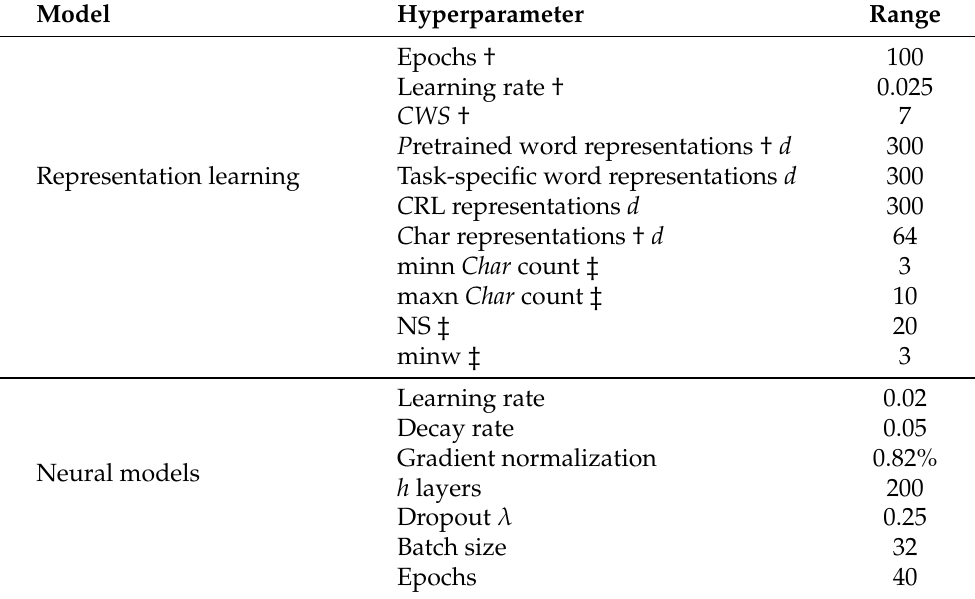
Table 4. Optimal hyperparameters for pretrained word-level and character-level (Char) SdGloVe and SdfastText representations, neural baselines, and the proposed CaBiLSTM model. † denotes the parameters for SdGloVe, SdfastText, and task-specific representations. ‡ denotes the parameters for SdfastText